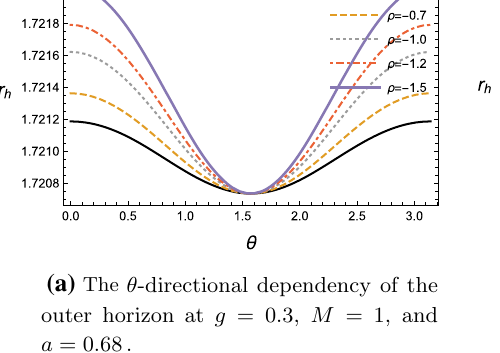
The θ -directional dependency of the outer horizon at g = 0 . 3, M = 1, and a = 0 . 68. Fig. 3 The outer horizon and its surface for a negative ρ